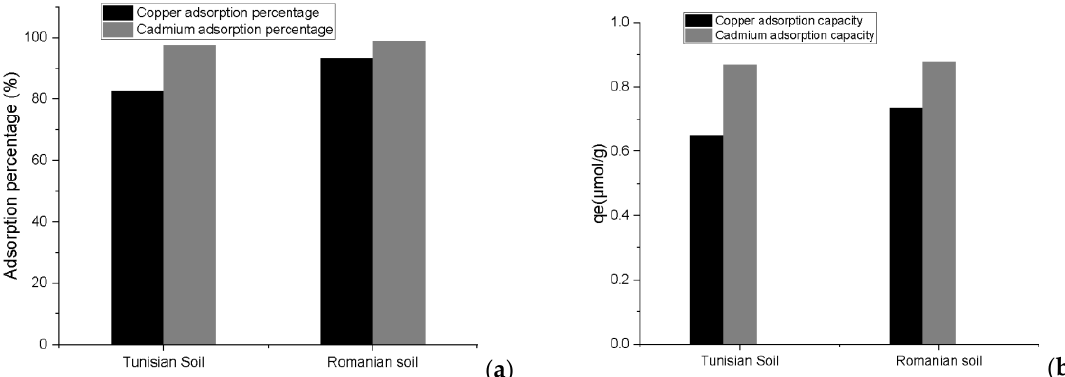
Figure 6. Copper and cadmium in Tunisian and Romanian soils ([Cu 2+ ] ≈ [Cd 2+ ] ≈ 0.1 mmol · L − 1 ): ( a ) adsorption percentage; ( b ) capacity.